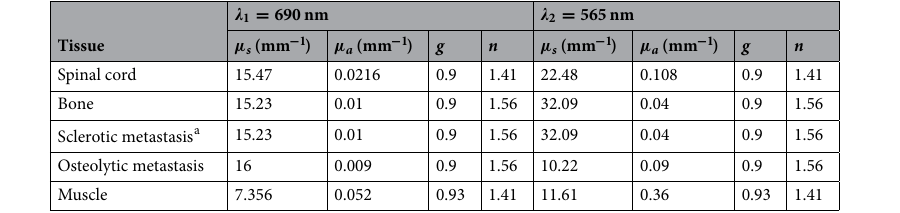
Table 2. Tissue optical properties for each region in the 3D model at two activation wavelengths ( (cid:31) 1 = 690 nm and (cid:31) 2 = 565 nm).